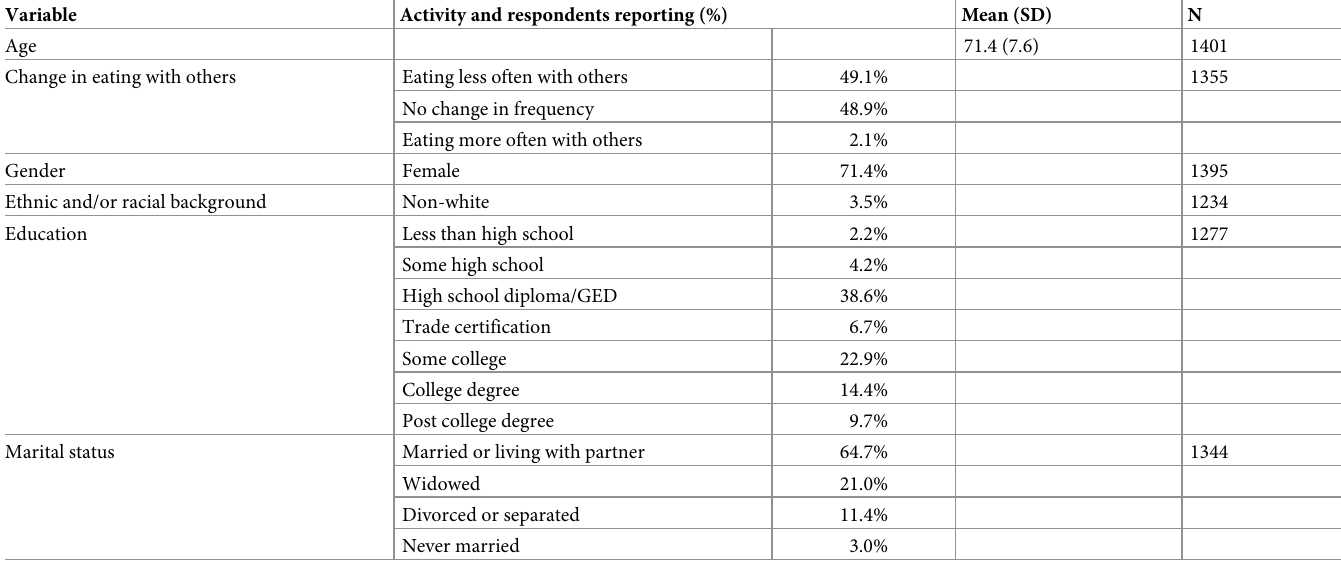
Table 2. Descriptive statistics for demographic variables included in statistical models.